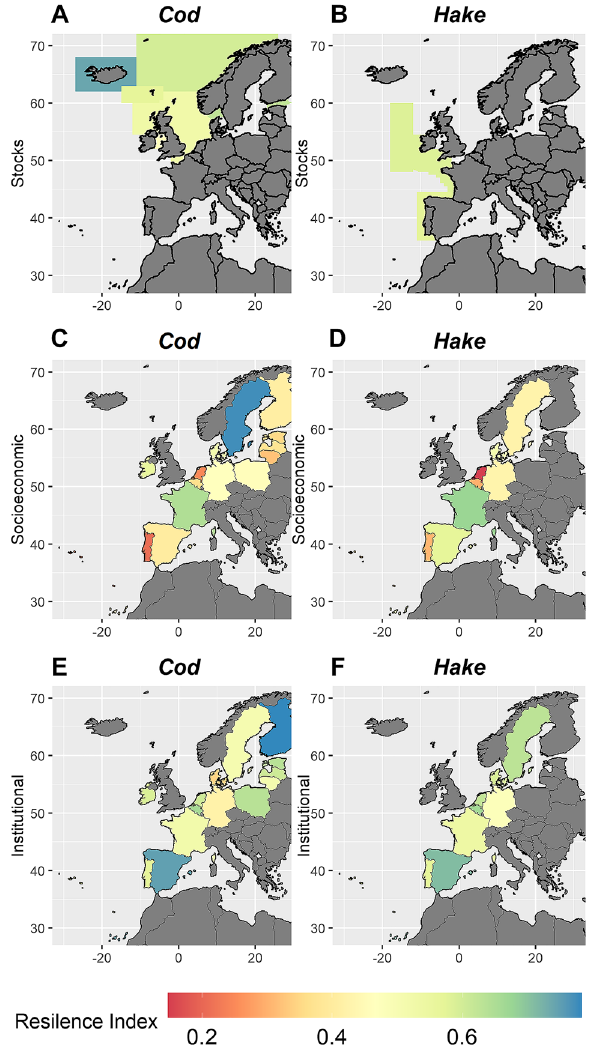
Figure 3. Results for the ecological, socioeconomic, and institutional resilience dimensions, per country and species. ( A and B ) represent ecologic, ( C and D ) socioeconomic, and ( E and F ) institutional dimensions. The maps created using the free package “rnaturalearthdata” in R 4.0.3 68